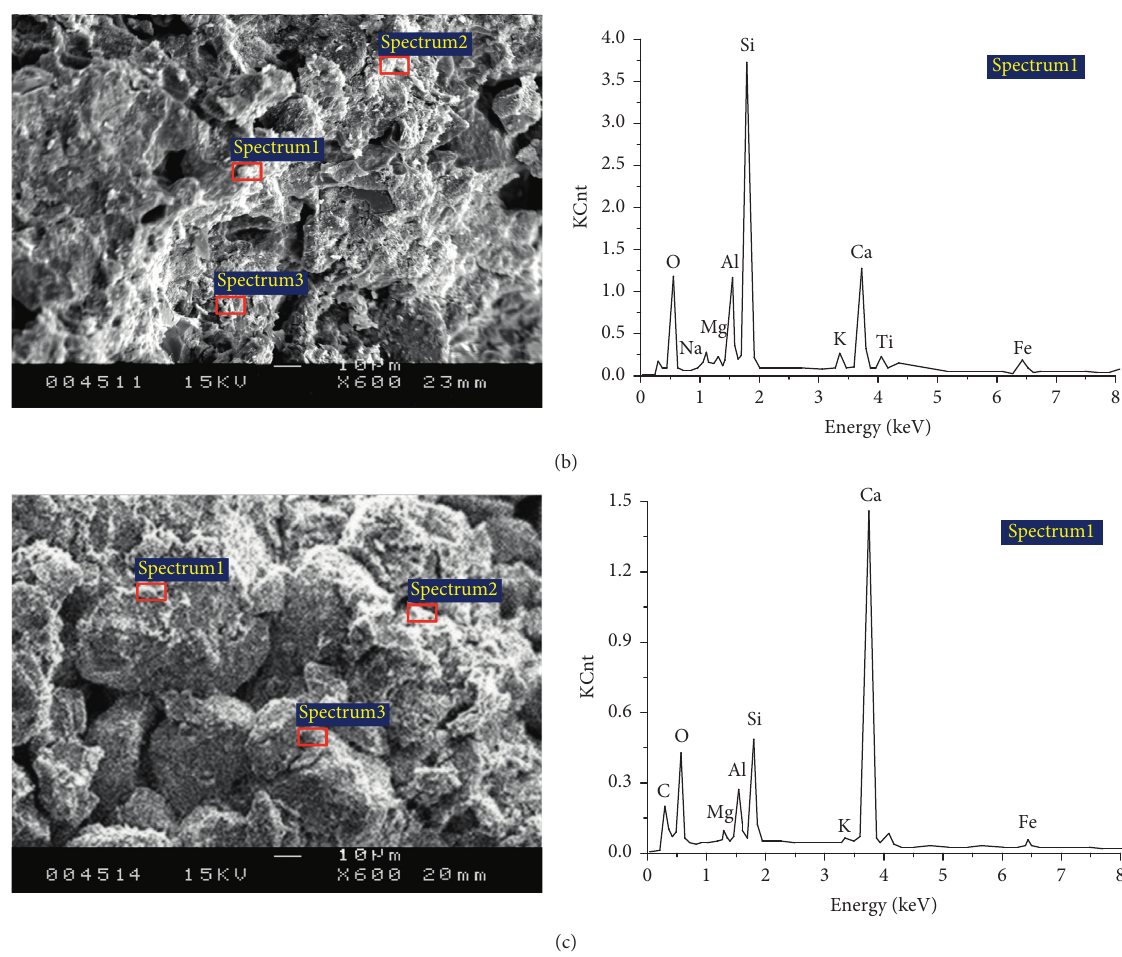
Figure 7: EDS test results of LF-YRAS and C2: (a) LF-YRAS, standard curing for 7d; (b) C2, standard curing for 7 d; (c) C2, standard curing for 28d.